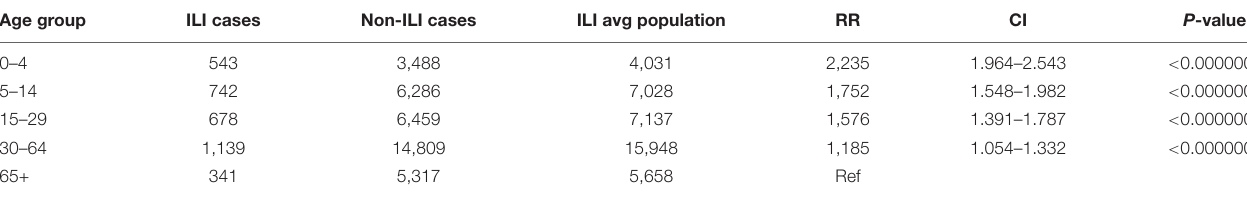
FIGURE 2 | Graphical representation of ILI and SARI positive cases divided by week and subtype. TABLE 1 | Statistically significant differences between all analyzed age groups compared to the respective population under surveillance.